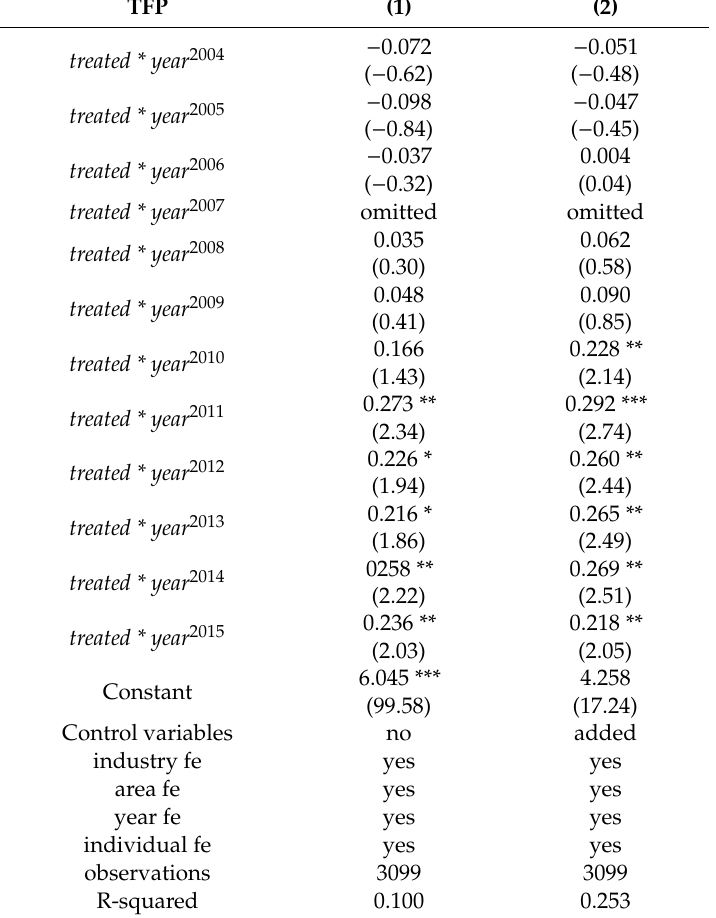
Table 3. Dynamic e ff ect of SO 2 emissions trading pilot (ETP) on